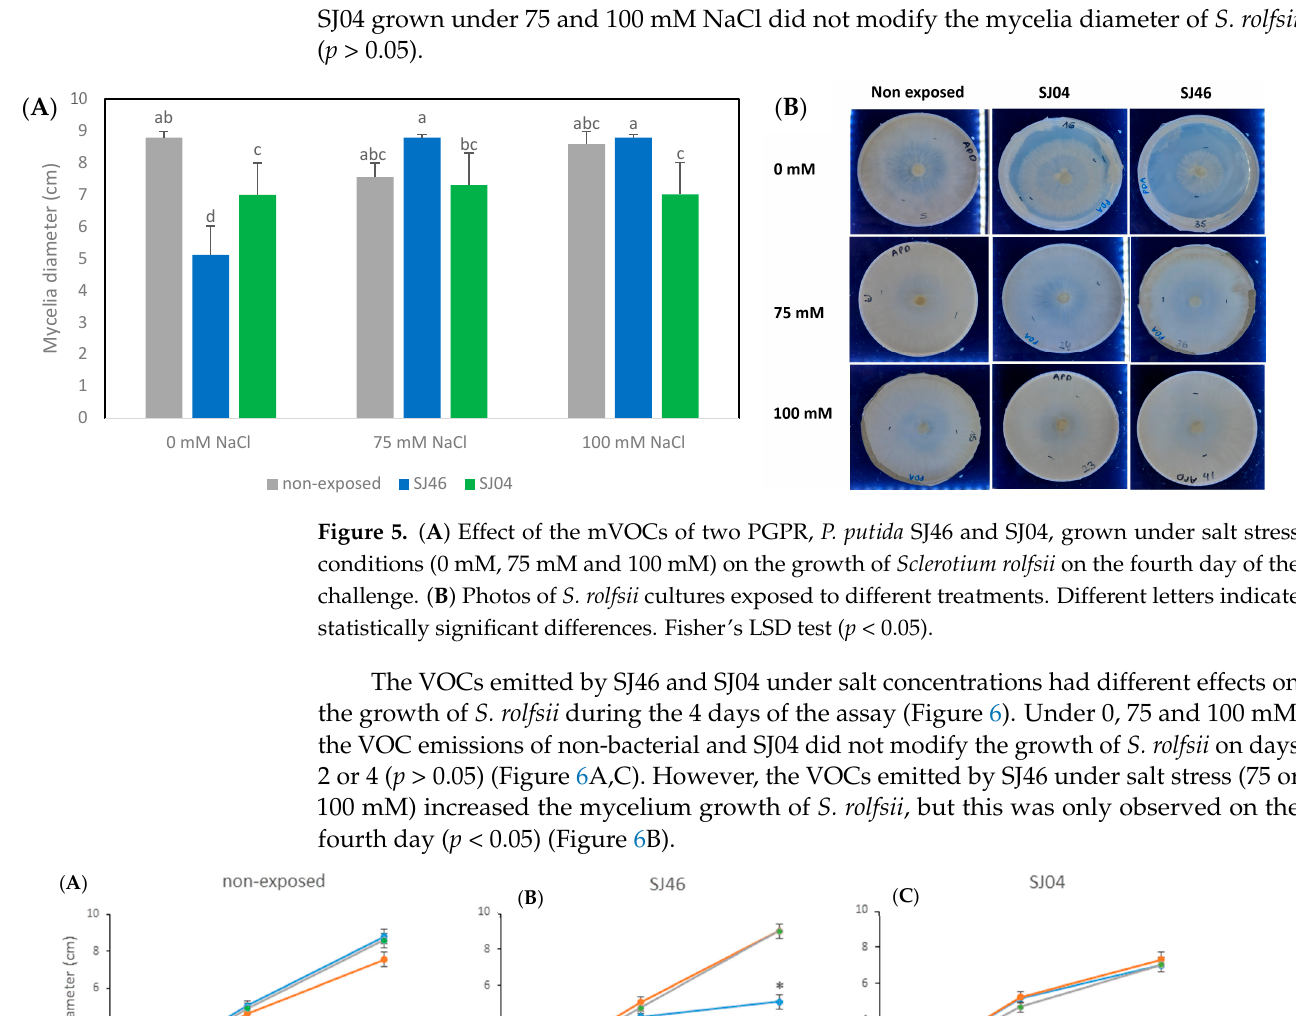
Figure 4. E ff ect of mVOCs of ( A ) control (non-exposed), ( B ) P. putida SJ46 and ( C ) SJ04 on A. alternata growing under di ff erent salt levels.